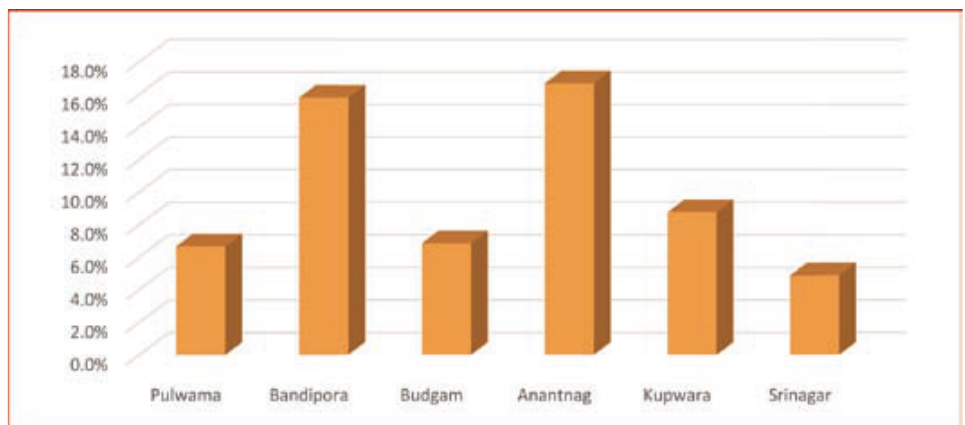
Fig. 1 Map of Kashmir showing sites of sample collection